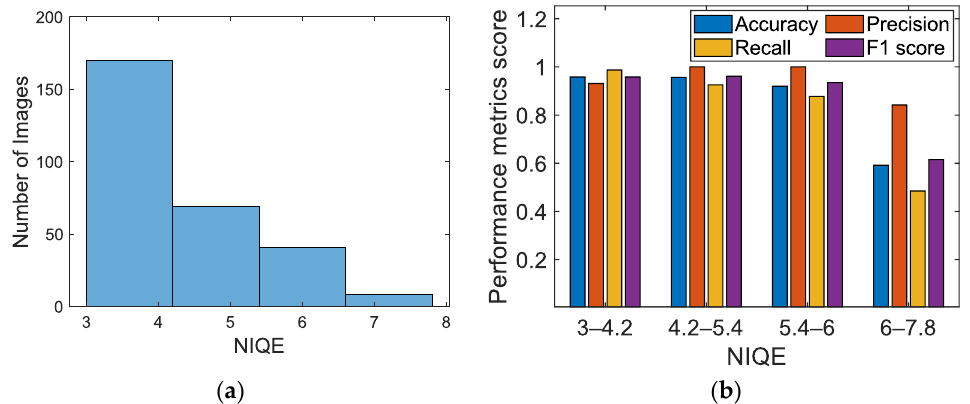
Figure 11. ( a ) Optical image quality that accounts for environmental uncertainty and optical variability of the database, quantified using natural image quality evaluation (NIQE) histogram. ( b ) Corresponding performance metrics scores for feature classification.